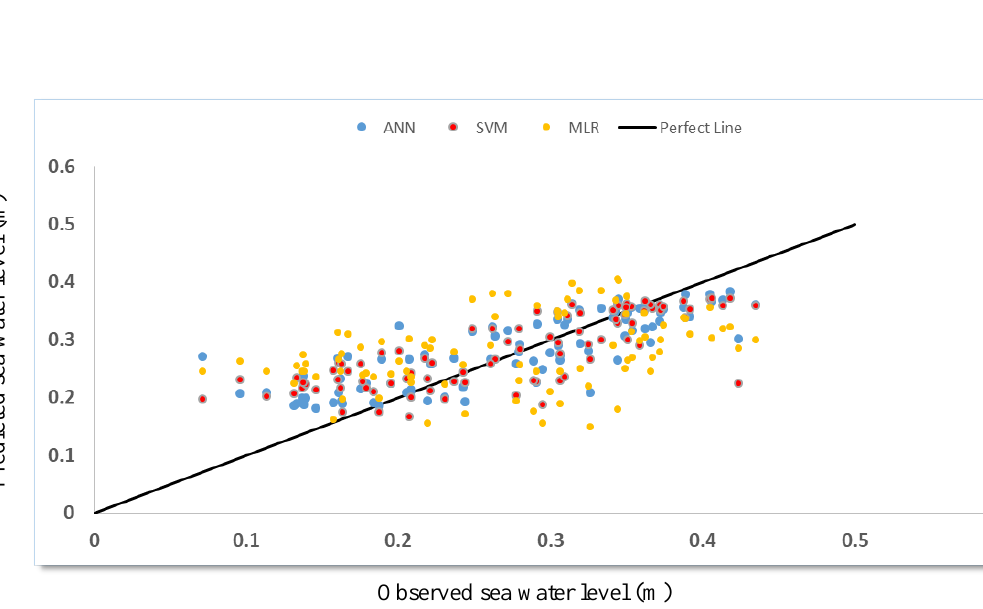
1251 | Vol. 6, No. 5, 2021